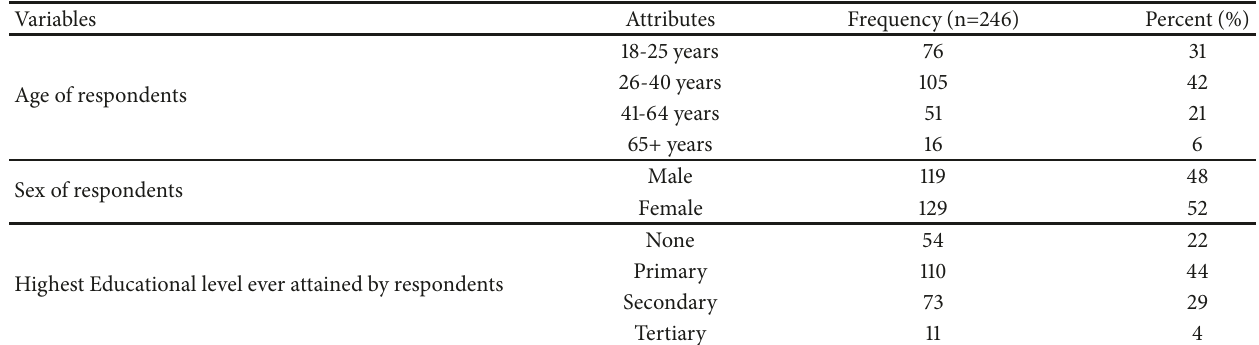
Table 1: Sociodemographic characteristics of